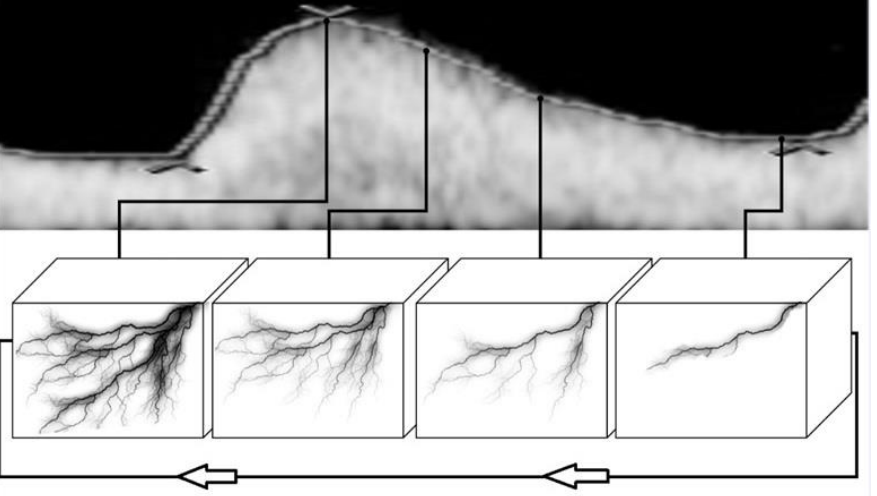
Figure 1. Schematic principle of creating a Spatio-Temporal Image Correlation (STIC) 4D record. A